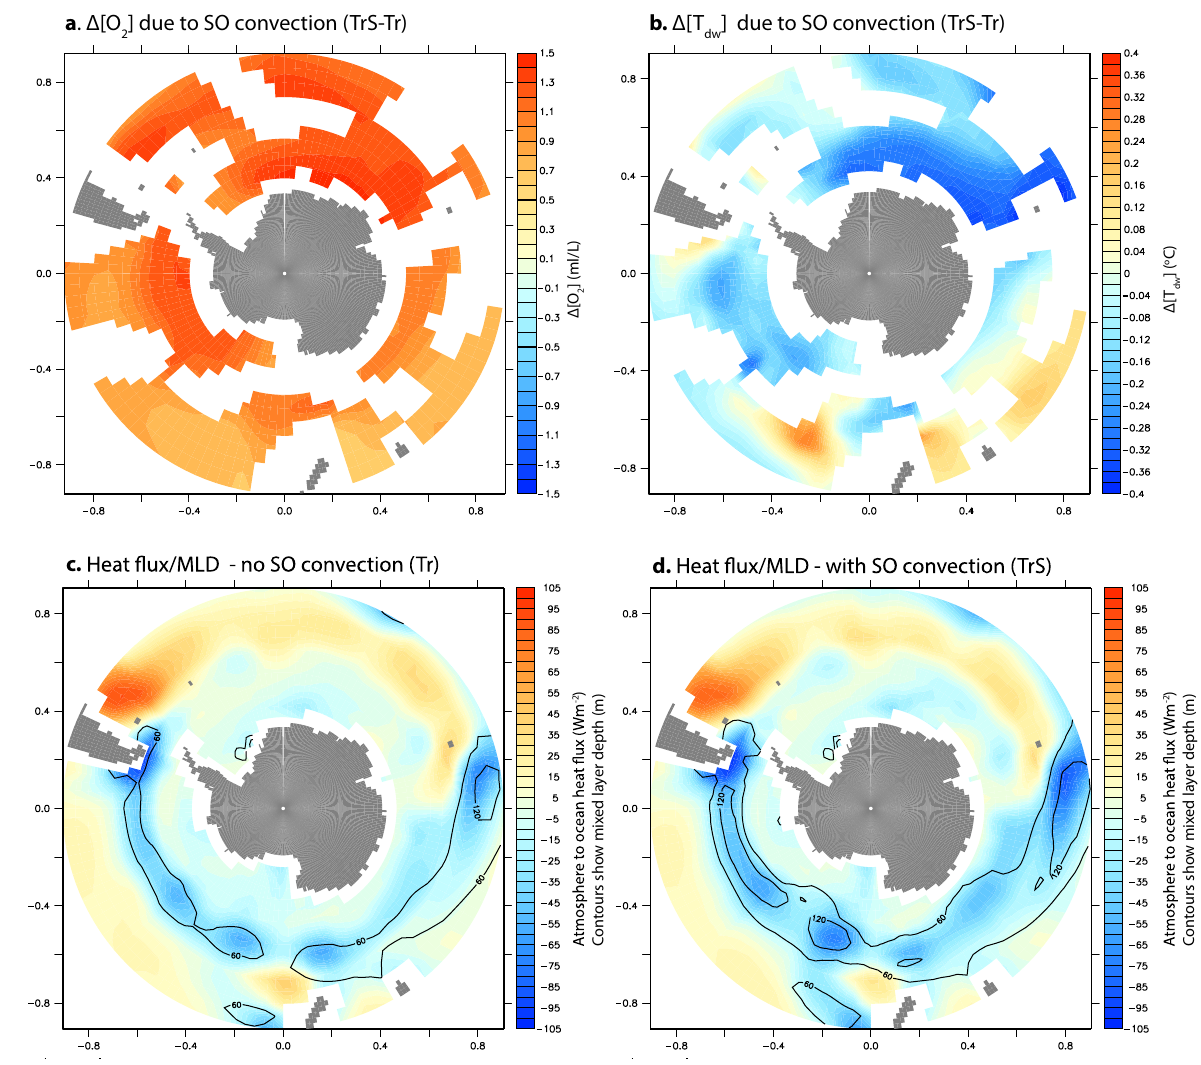
Fig. 4 The thermal- and oxygenation ‘ fi ngerprint ’ of enhanced Southern Ocean convection, based on numerical model simulations 12 . a Impact of enhanced convection on deep-water oxygenation (3300 – 4000 m depth), based on the difference between composites of UVic and LOVECLIM simulations of HS4 with- (Tr – S) and without (Tr) enhanced Southern Ocean convection; b as for ( a ) but for deep-water temperature; c atmosphere to ocean heat fl ux (shading; negative values indicate increased heat fl ux out of the ocean), and mixed layer depth (MLD, contours) for composite of UVic and LOVECLIM simulations of HS4, without enhanced Southern Ocean convection; d as for ( c ), but for simulations with enhanced Southern Ocean